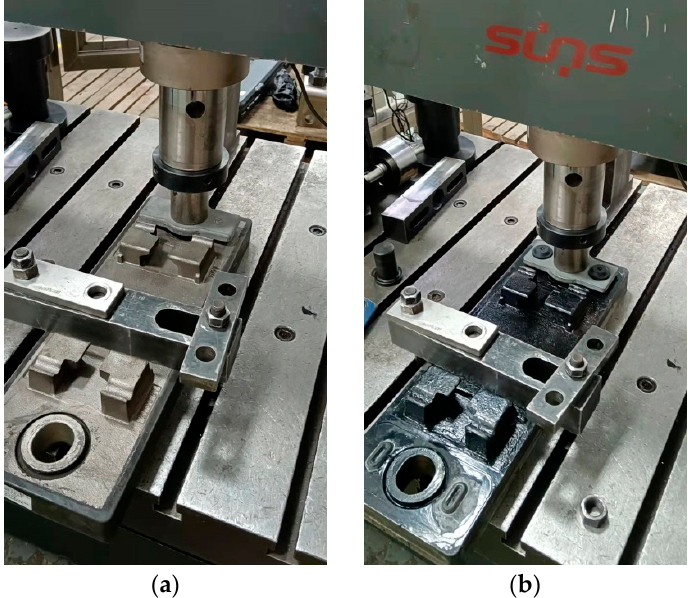
Figure 5. Experiment setup for experiment conditions ( a ) 1 and ( b )